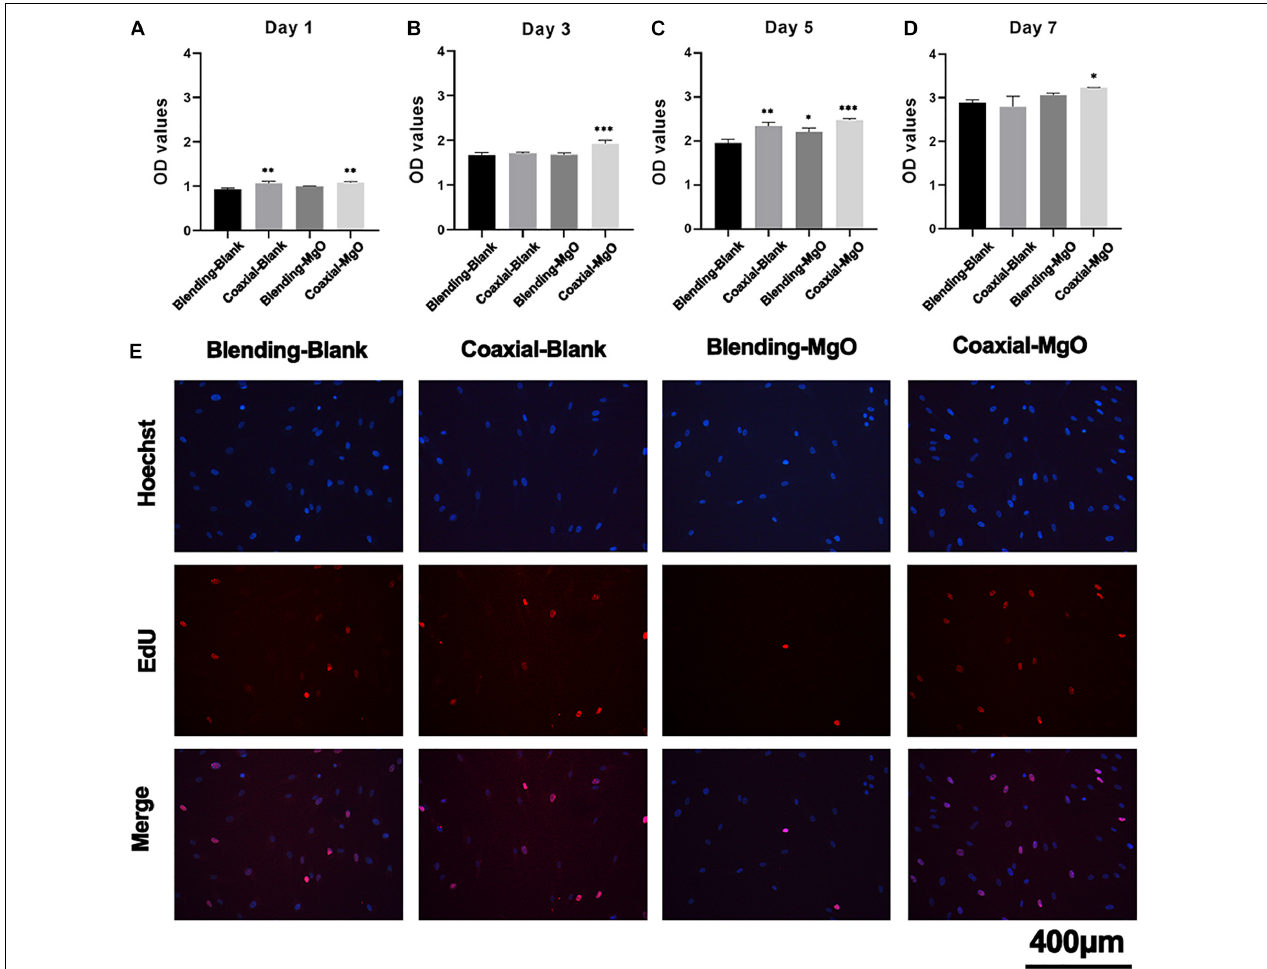
FIGURE 3 | Biocompatibility of electrospun membranes. hPDLSCs were cultured on Blending-Blank, Coaxial-Blank, Blending-MgO, and Coaxial-MgO, respectively, for (A) 1, (B) 3, (C) 5, and (D) 7 days, and the cell viability was compared by the OD value using a CCK-8 kit. (E) Cell proliferation of hPDLSCs seeded on the electrospun membranes after 12 h were analyzed by EdU staining. Red, EdU-labeled nuclei of proliferative cells; Blue, Hoechst 33342-labeled cell nuclei.